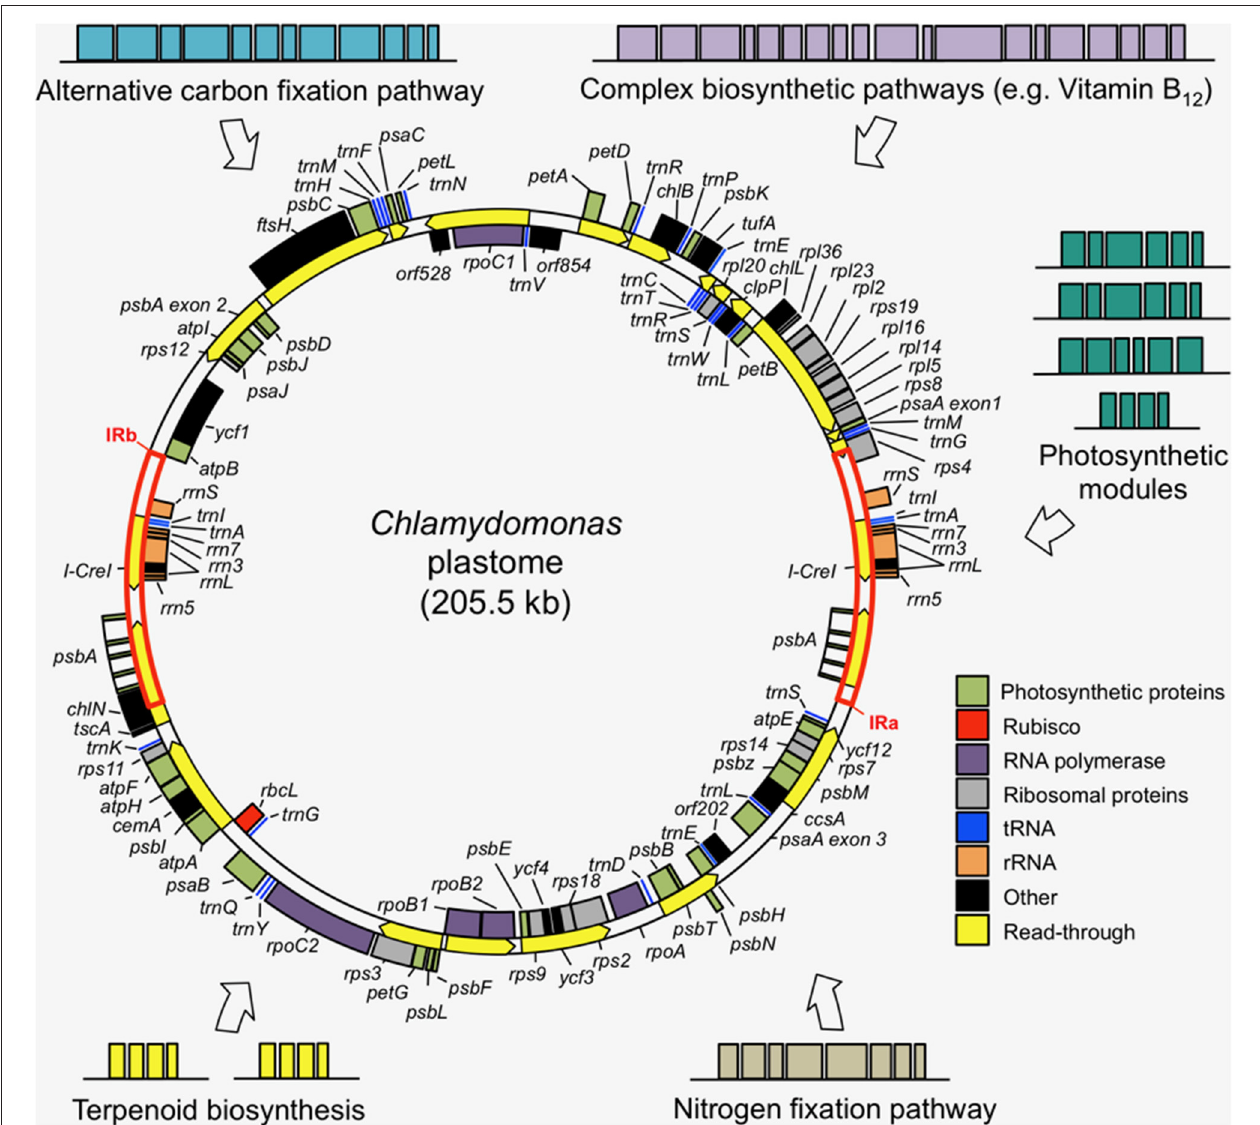
FIGURE 2 | Examples of transgene modules that could be added to the Chlamydomonas plastome to introduce novel metabolisms into the chloroplast. The wild-type plastome is composed of two single copy regions separated by two inverted repeats (IRa and IRb), with most genes encoding key subunits of the photosynthetic complexes and the transcription and translation machinery. The simplicity and tractability of the plastome make it a well-suited genetic system for complex metabolic engineering efforts. The plastome map was produced using the Cpv4 genomic data (Gallaher et al., 2018) with transcriptional read-through annotations (yellow arrows) from Cavaiuolo et al.